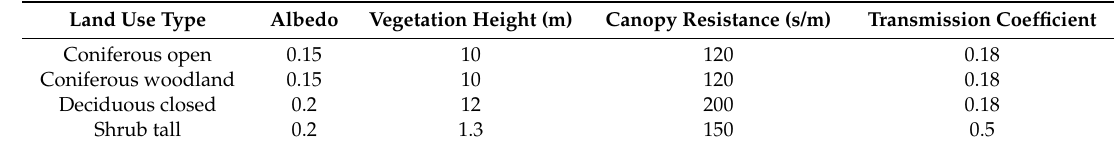
Table 5. Evapotranspiration parameter